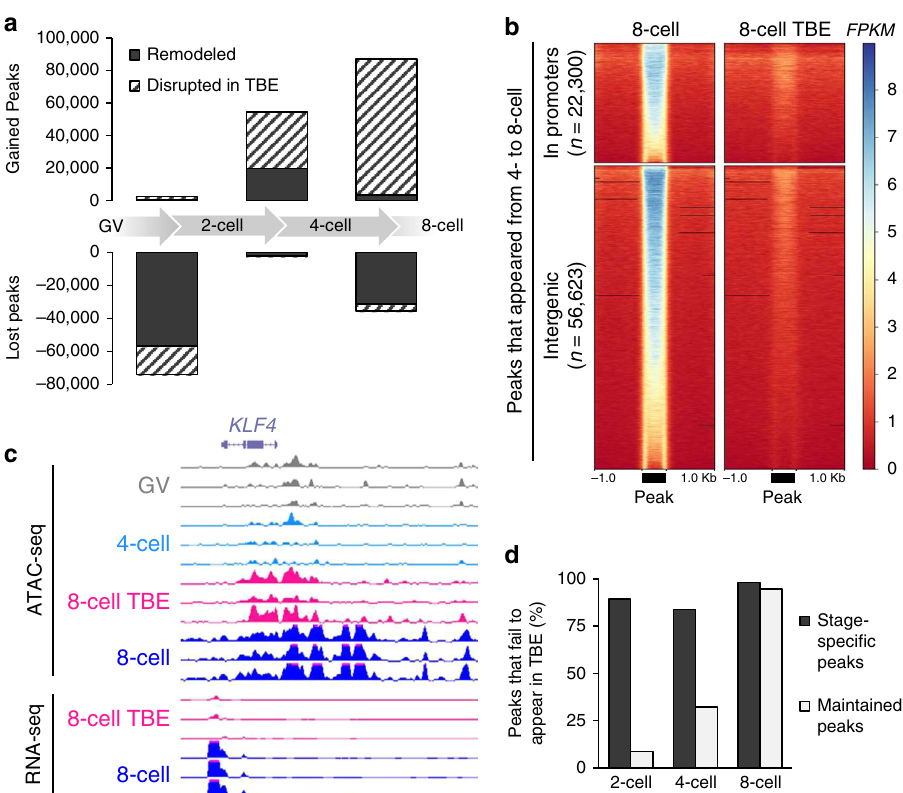
Fig. 4 Effect of transcription inhibition on chromatin remodeling. a Transcription inhibition effect on loci that should have opened or closed between consecutive stages. Peaks called from 20 million reads per stage. b Normalized ATAC-seq signal (FPKM) in control and transcription inhibited 8-cell embryos at peaks which were gained between the 4- and 8-cell stage. Peaks scaled to 500 bp. c Normalized ATAC-seq (FPKM) and RNA-seq signal (reads per kilobase million; RPKM) in 8-cell control and TBE at the KLF4 locus. RNA-seq data from Bogliotti et al. 23 . d Proportion of stage-speci fi c and maintained peaks that should appear at each stage, but which fail to appear in TBE. Source data are provided as a Source Data fi